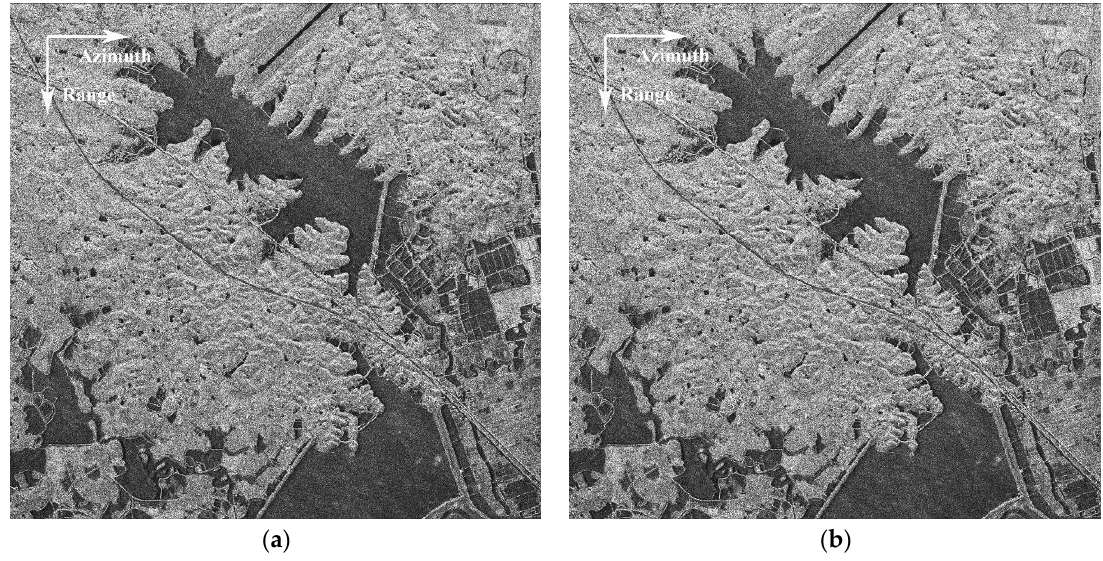
Figure 4. SAR imagery of the highway region: ( a ) fore-channel image; and ( b ) aft-channel image.